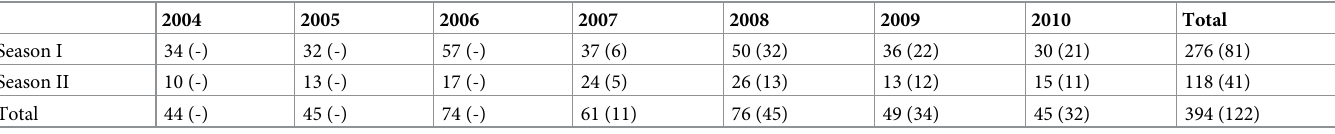
Table 2. Number of detected and radio-tracked